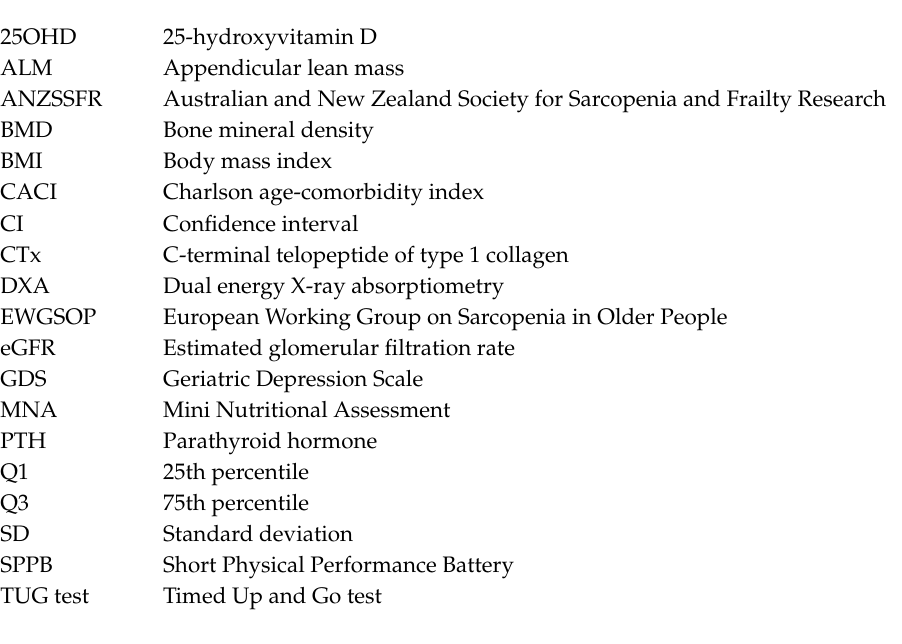
Table S1: The Charlson age-comorbidity index (CACI), Table S2: Cross-sectional associations of baseline nutritional status with baseline musculoskeletal